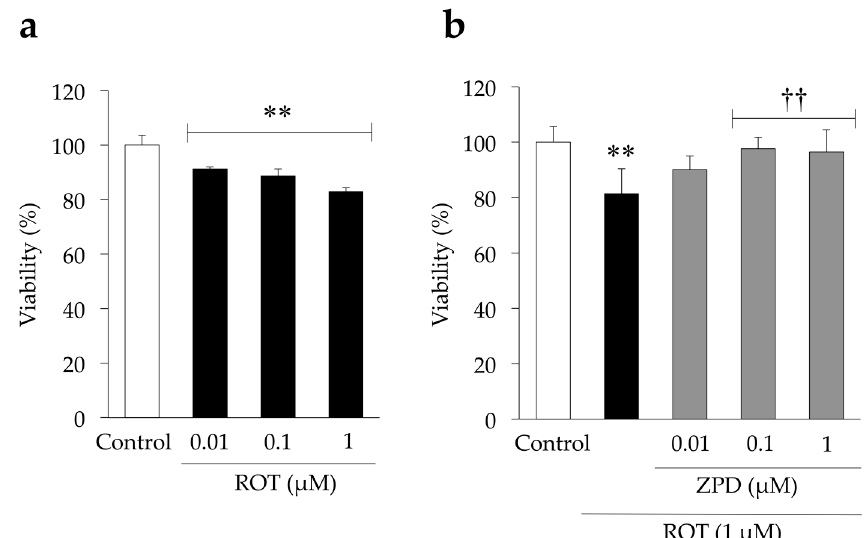
Figure 4. Effects of rotenone (ROT) and ziprasidone (ZPD) on viability of PC12 cells. Cells were incubated with various concentrations of ( a ) ROT and ( b ) ROT and ZPD for 24 h. Cell viability was determined by CellTiter-Blue assay. Experiments were repeated at least three times, and the values represent the mean of three experiments ± standard deviation (SD). ** p < 0.01 versus Control. †† p < 0.01, compared with ROT-treated cells.